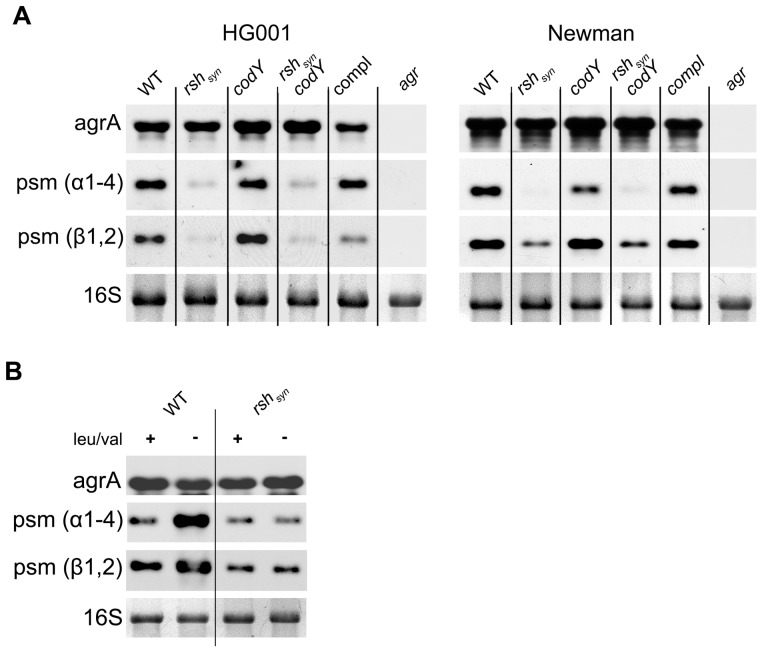
(p)ppGpp dependent psm expression during stringent response.(A) (p)ppGpp dependent activation of target genes in two different S. aureus strains. Strain HG001 (WT) and strain Newman (WT), the corresponding rshSyn mutants, codY mutants, rshsy
n, codY double mutants, the complemented rshSyn mutants (compl) and the agr mutants were grown in CDM to the exponential growth phase (OD600 = 0.5) followed by further incubation in medium without (−) leu/val for 30 minutes. (B) Wild-type strain HG001 and its isogenic rshSyn mutant were incubated with (+) or without (−) leu/val for 30 minutes. RNA was hybridized with digoxigenin-labelled PCR fragments. The 16S rRNA detected in the ethidium bromide-stained gels is indicated as loading control in the lower lane.